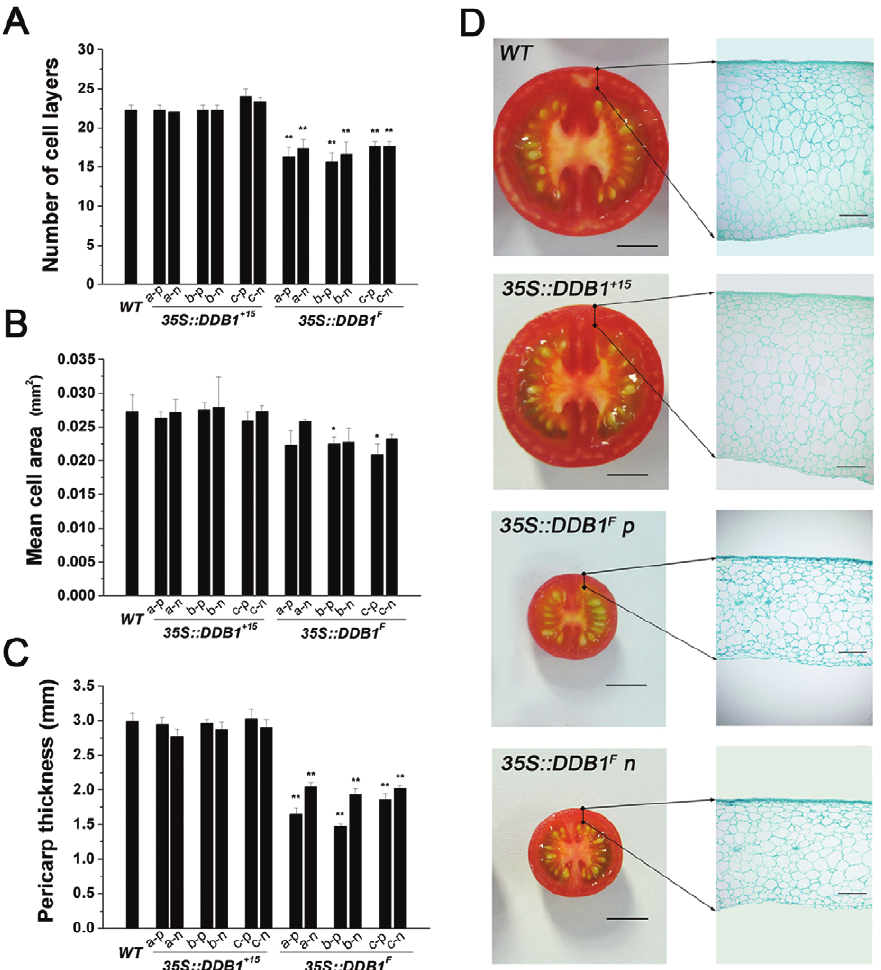
Figure 4. Cellular parameters of pericarp of fruits at breaker stage from WT Ailsa Craig ( WT ) and DDB1 overexpression lines. (A) Number of cell layers across pericarp. (B) Mean cross-sectional area of one pericarp cell. (C) Pericarp thickness. (D) Cross section of fruit (left) and pericarp (right) are shown for WT Ailsa Craig ( WT ), 35S::DDB1 + 15 and 35S::DDB1 F T 2 transgenic lines. p and n represent plants with or without transgene, respectively. Bar: 1 cm (F, left sections), 500 m m (F, right sections).